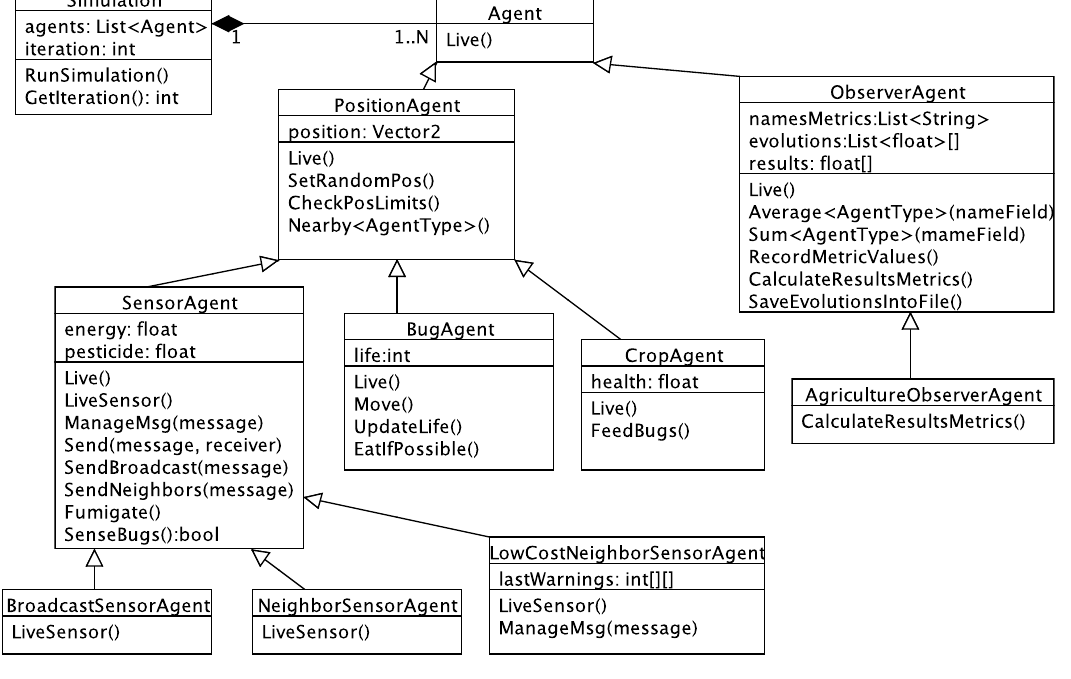
Figure 2. Class diagram of the excerpt of ABS-SmartComAgri concerning its agent